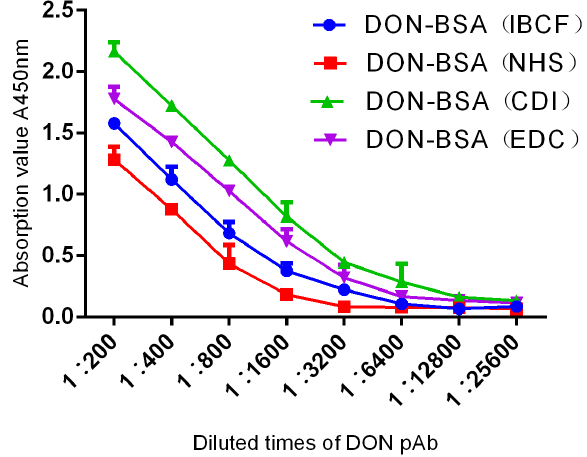
Figure 4. The titre curves of DON pAb identification.